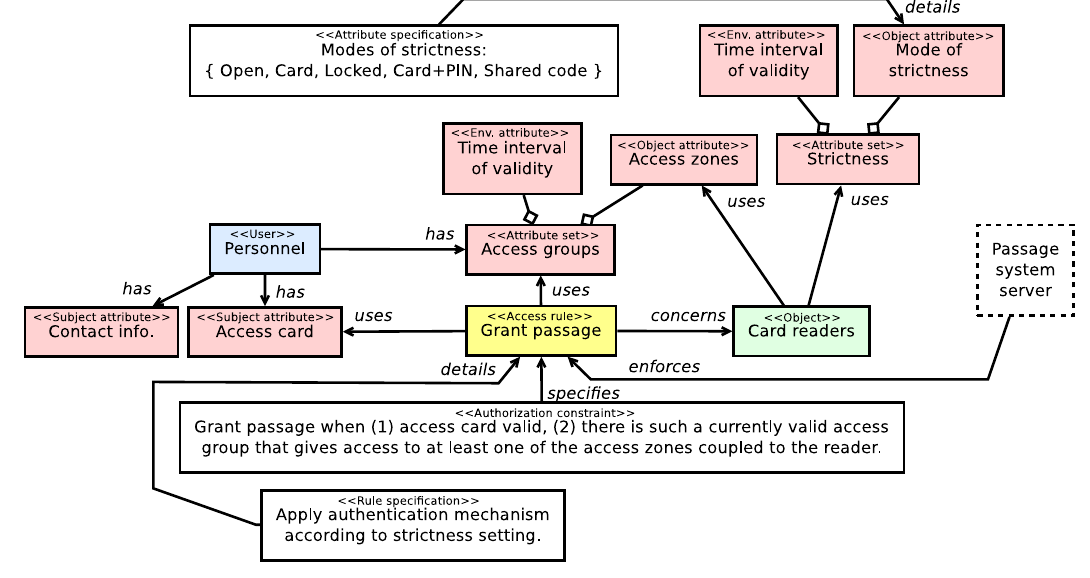
Figure 7. Model of Business case 2: Authorization configuration of a passage system in an office building (simplified, omitting concrete users, access zones and other